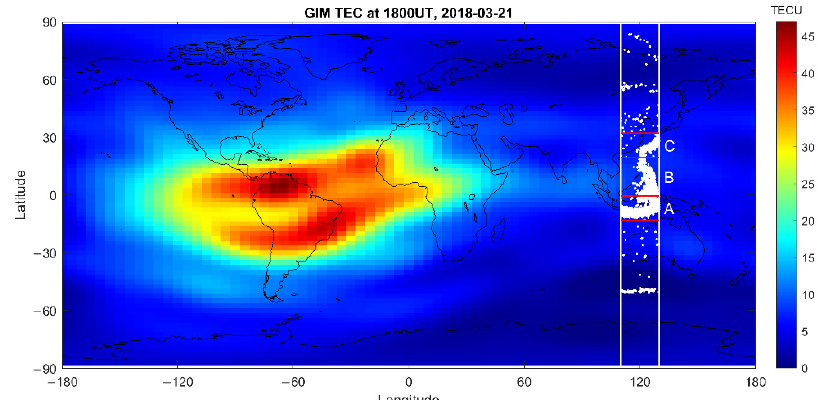
Figure 1. The distribution of earthquakes of magnitude ≥ 2.5 occurring within 110–130°E longitude from 1 January 2015 to 31 December 2018 (white dots), and the global distribution of GIM TEC observed at 1800 UT on 21 March 2018 in TEC units (1 TECU = 10 16 electron/m 2 ). Two vertical white lines denote longitudes of 110 and 130°E. The three study Regions A (13°S–0.5°S), B (0.5°S–19.5°N), and C (19.5°N–32.1°N) are divided by four red lines. The equatorial ionization anomaly (EIA) can be seen between approximately –150 and 30°E longitudes.